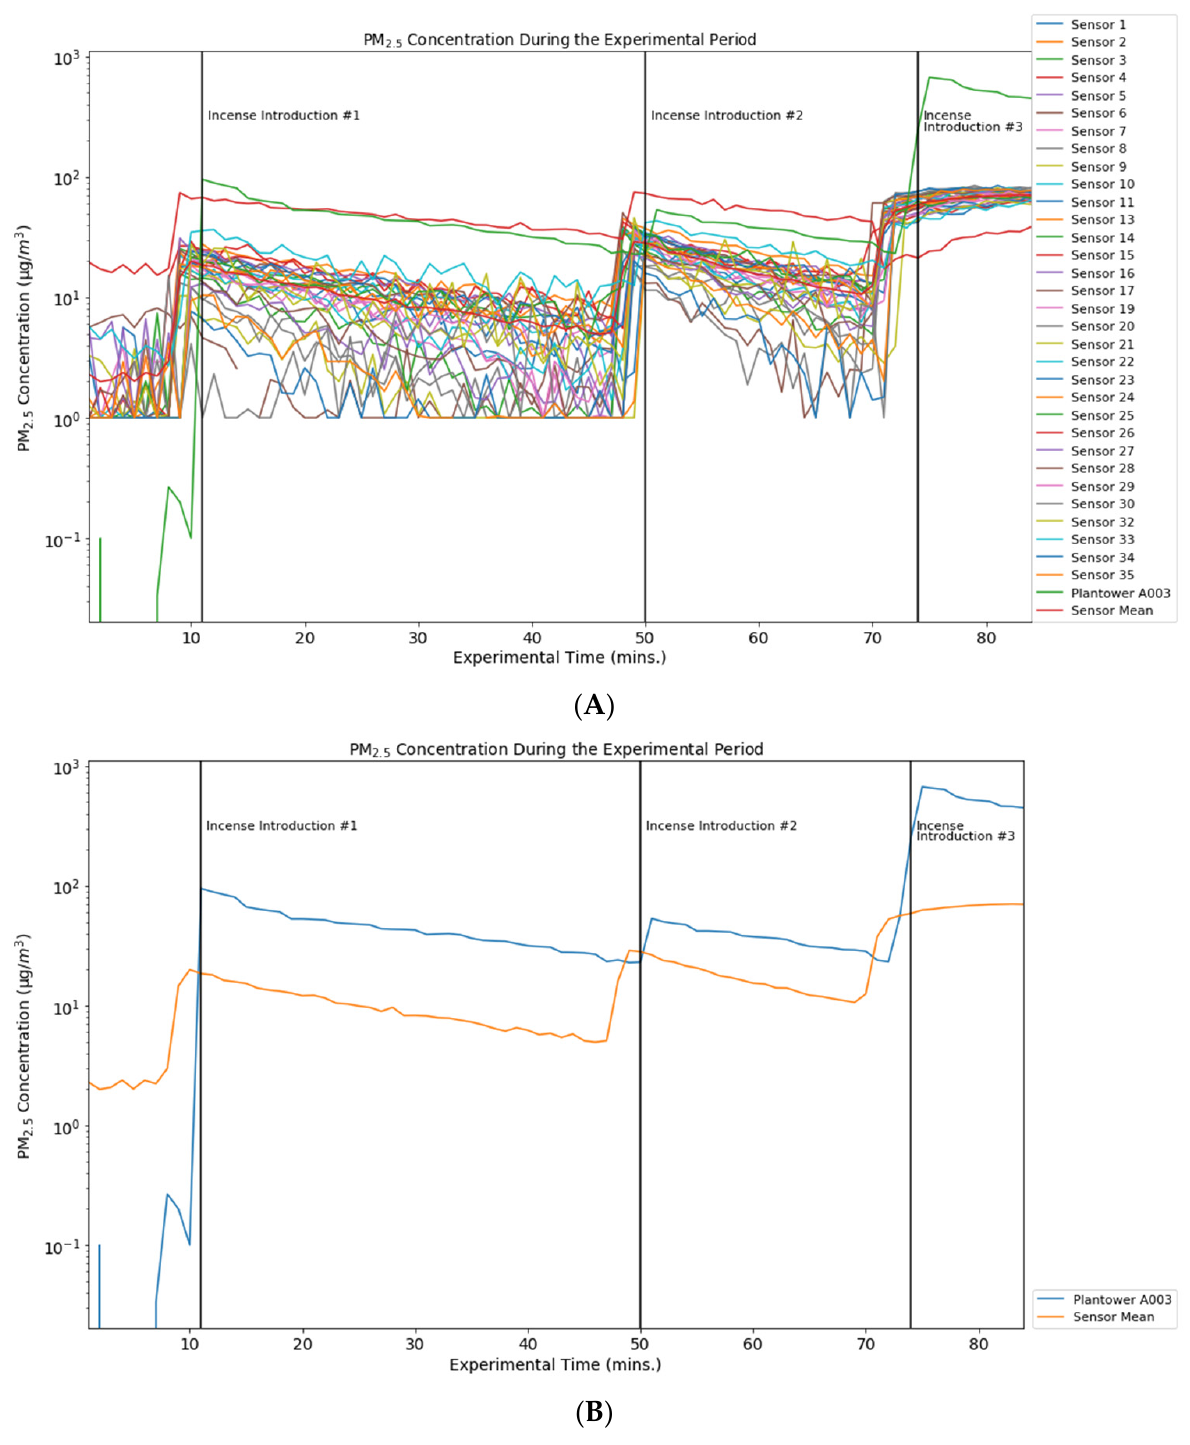
Figure 1. PM 2.5 Concentration During the Experiemental Period Featuring Data from 32 Flow Sensors Individually ( A ) and in Aggregate ( B ) vs. Plantower A003.